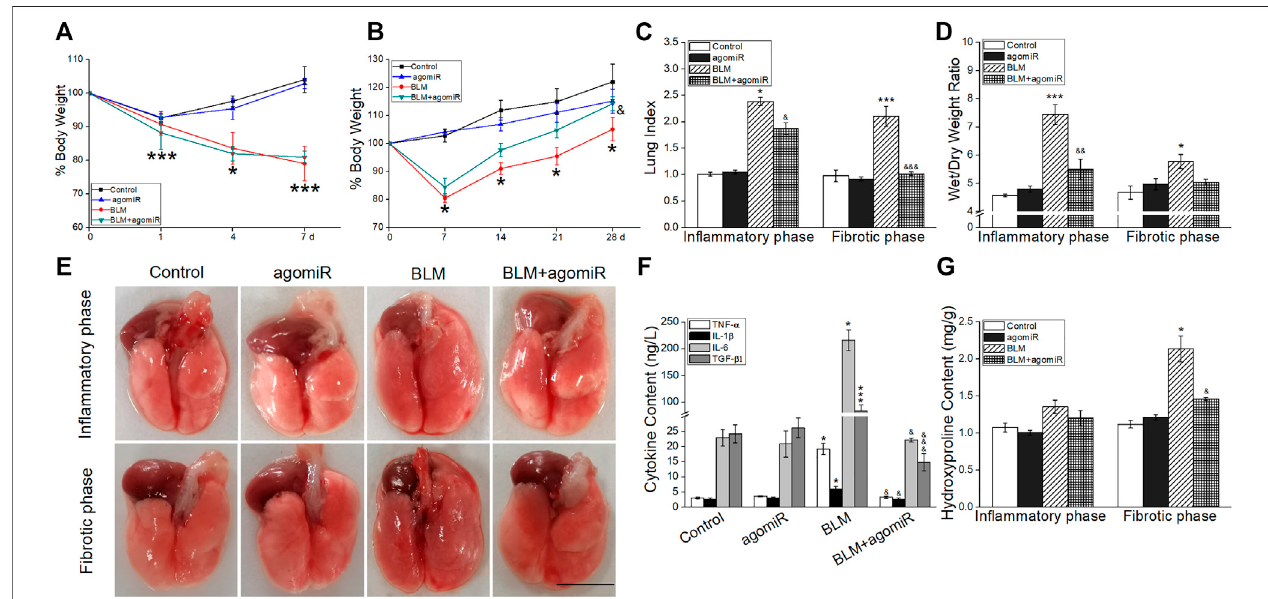
FIGURE 4 | Effect of miR-130a-3p agomiR on pulmonary in fl ammation and collagen deposition. (A-B) Mouse body weight changes in the course of the in fl ammatory phase or fi brotic phase after BLM induction. * p < 0.05, *** p < 0.001, versus the control group; & p < 0.05, versus the BLM group, by the Mann – Whitney U test, n =3 – 5. (C) Lungindex(%). (D) Wet/dryweightratio.* p < 0.05, *** p < 0.001,versusthecontrolgroup; & p < 0.05, && p < 0.01, &&& p < 0.001,versustheBLM group, one-way ANOVA followed by Bonferroni ’ s test, n = 3 – 5. (E) Representative photographs of whole lungs from all the experimental groups. Scale bar = 1 cm. (F) TNF- α , IL-1 β ,and IL-6levels in BALF of thein fl ammatoryphase. * p < 0.05, versusthe control group; & p < 0.05, versus theBLM group, bythe Mann – Whitney U test, n